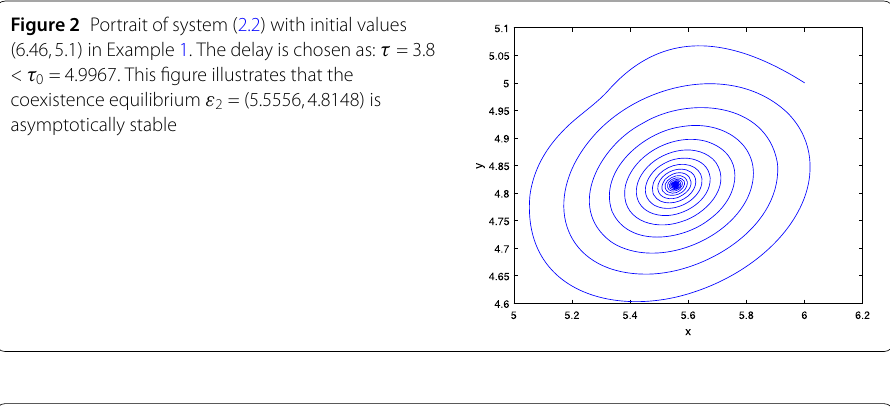
Figure 2 Portrait of system (2.2) with initial values (6.46,5.1) in Example 1. The delay is chosen as: τ = 3.8 < τ 0 = 4.9967. This figure illustrates that the coexistence equilibrium ε 2 = (5.5556,4.8148) is asymptotically stable